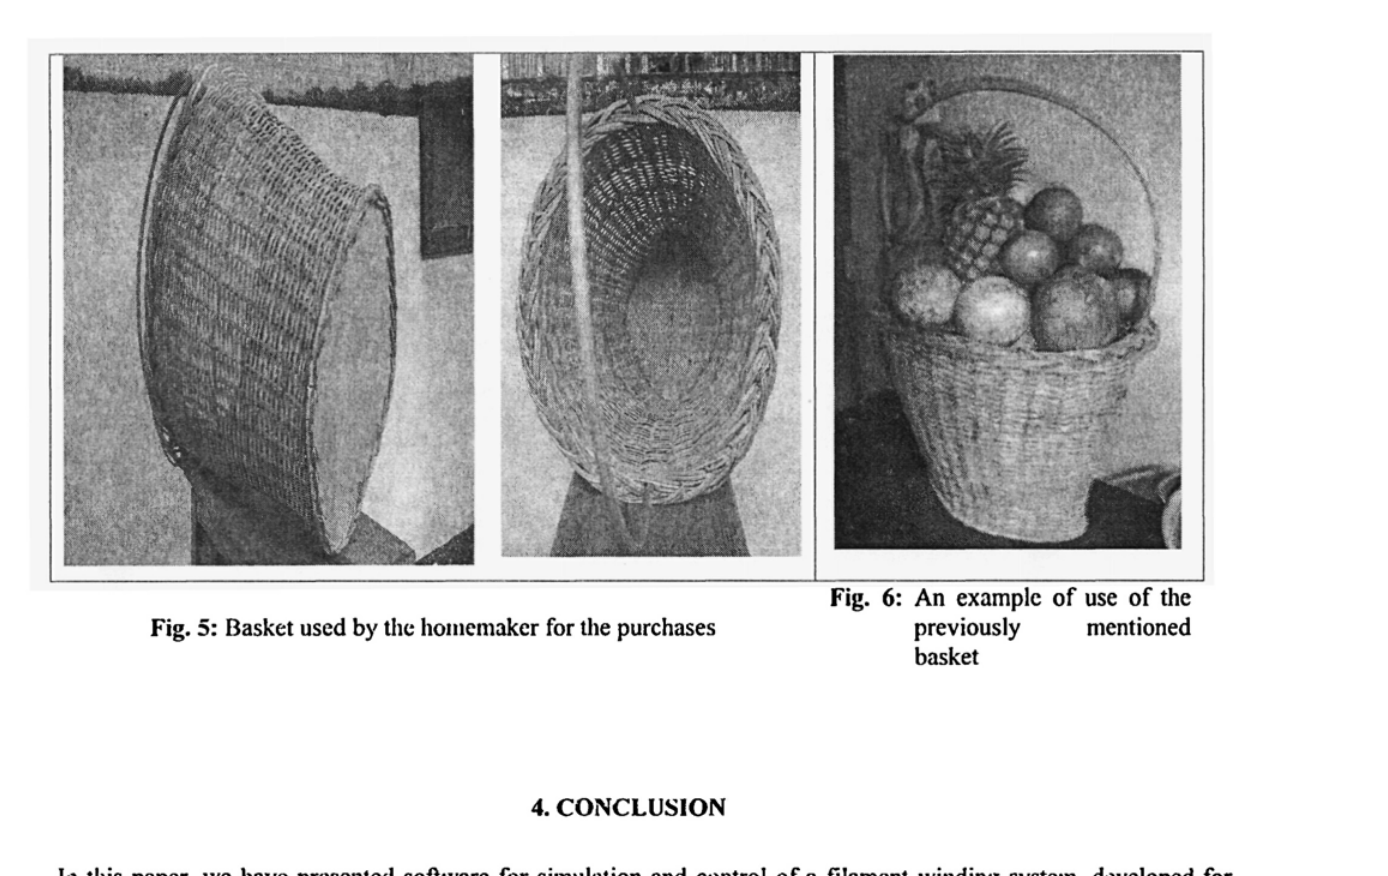
Fig. 5: Basket used by the homemaker for the purchases